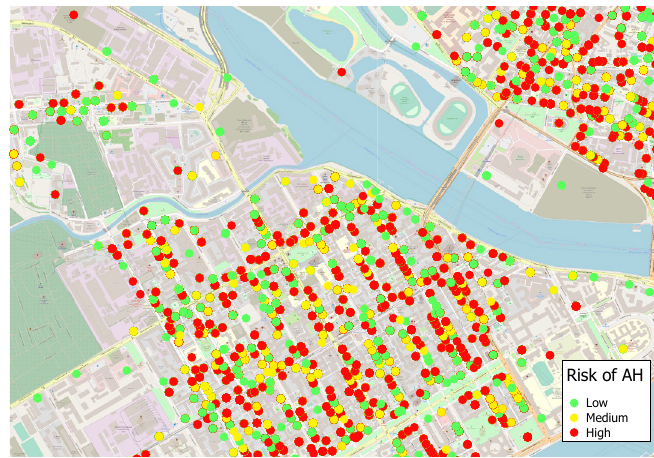
Figure 2. The distribution of individuals of di ff erent risk categories to arterial hypertension